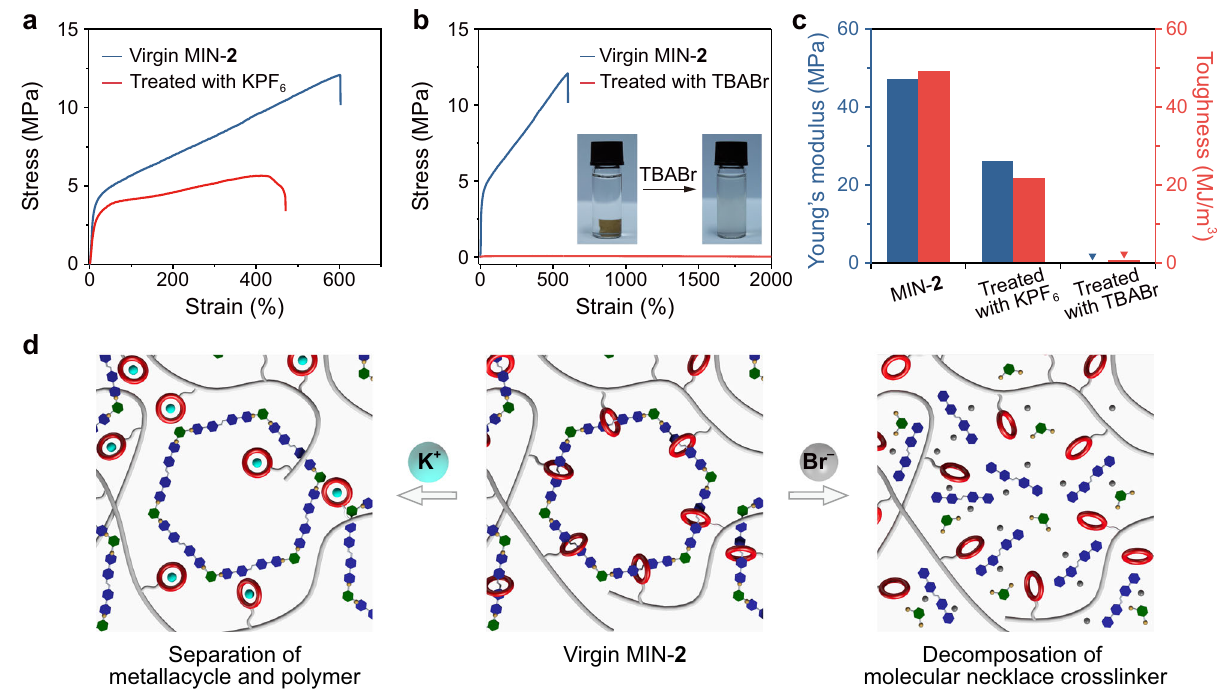
Fig. 6 Stimuli-responsive properties of MIN-2. a Stress – strain curves of the virgin MIN- 2 and the one after being treated with KPF 6 . b Stress – strain curves of the virgin MIN- 2 and the one after being treated with TBABr. Inset: dissolution of MIN- 2 in acetone in the presence of TBABr. c Young ’ s moduli and toughness of virgin MIN- 2 as well as the KPF 6 and TBABr-treated samples calculated from their stress – strain curves. d Schematic representation of the separation of DB24C8-based polymer and metallacycle triggered by KPF 6 (left), and the decomposition of molecular necklace triggered by TBABr (right). NATURE COMMUNICATIONS| (2022) 13:1393